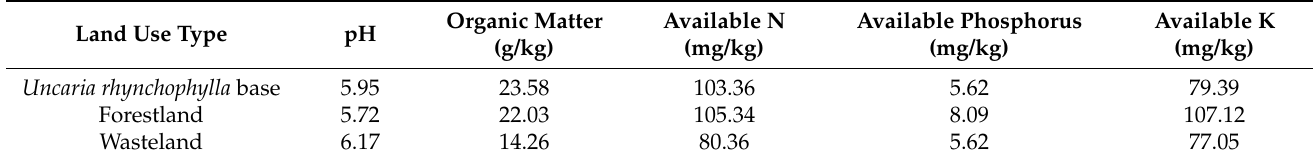
Figure 1. Geographical location of the study area. Table 1. Soil physicochemical properties in the study